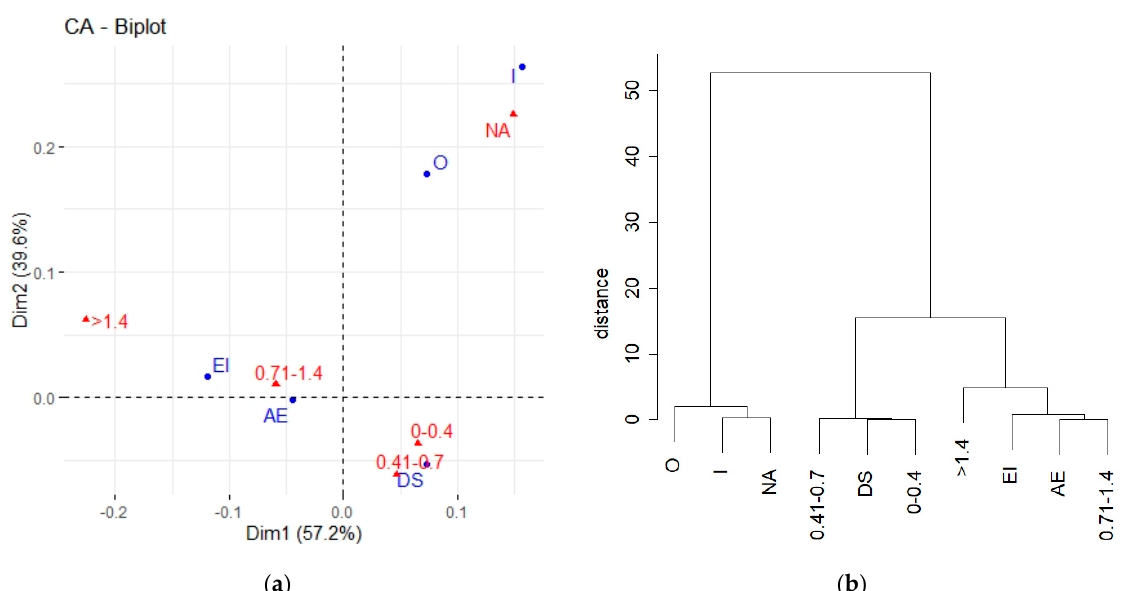
Figure 6. Correspondence map ( a ) and an auxiliary dendrogram ( b ) showing the dependence of each behavioural type of energy consumer on their average monthly income.